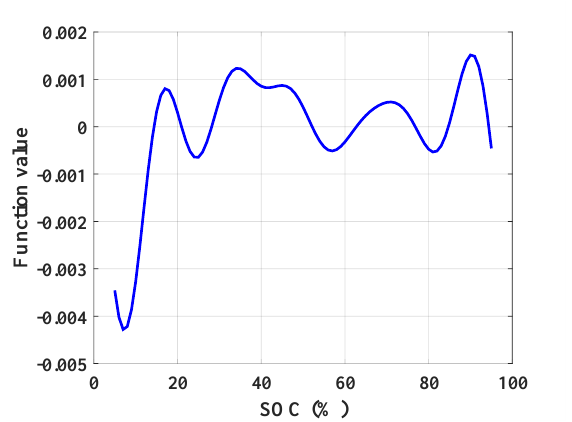
Figure 9. Values of the partial derivative function in (32) for the state in the overall feasible